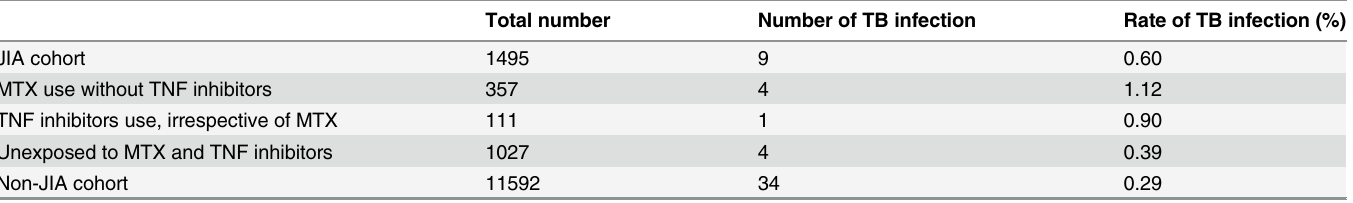
Table 2. Tuberculosis infection rates by disease cohort and medication